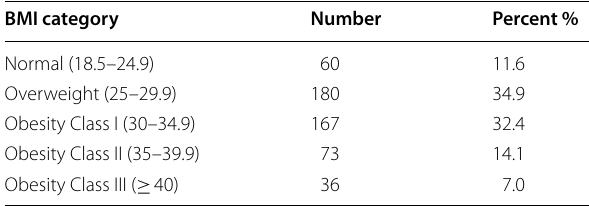
Table 2 Obesity distribution among the study population